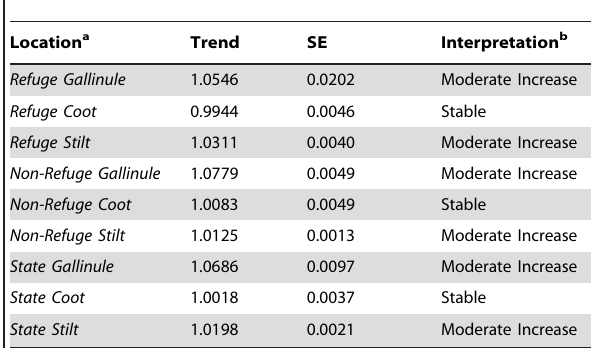
Table 2. Annual population trends for the Hawaiian Coot, Stilt, and Gallinule from count data spanning 1986–2007 in Hawai’i,